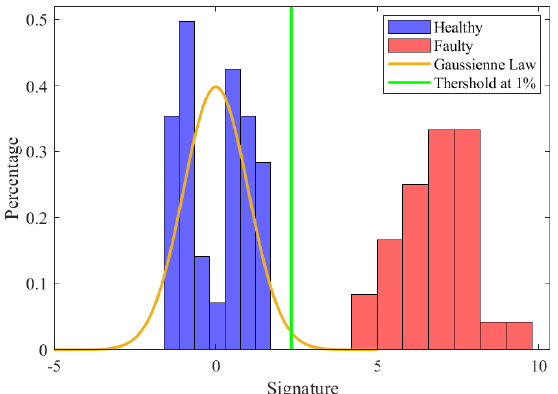
Figure 15. Histogram distribution of fault signatures using 30 measures.